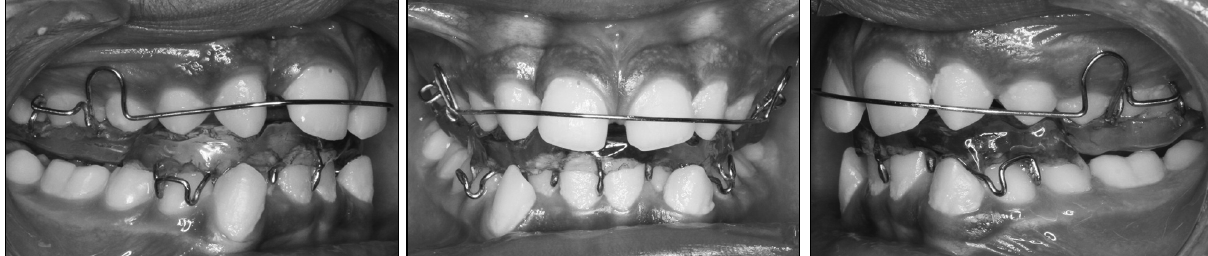
Figure 2. Upper lateral incisor extraction and Twin Block appliance for advancement of